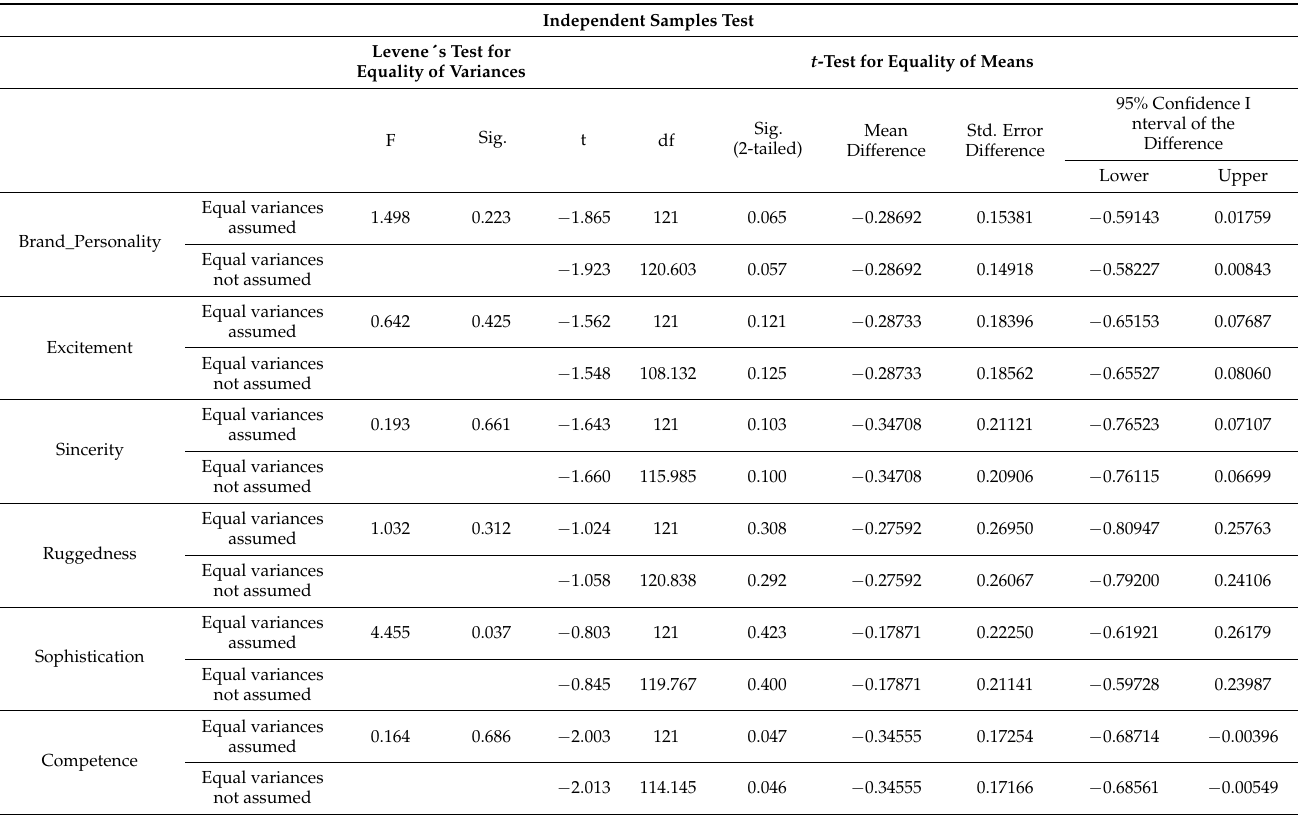
Table 9. Independent sample t-test. Brand personality types and